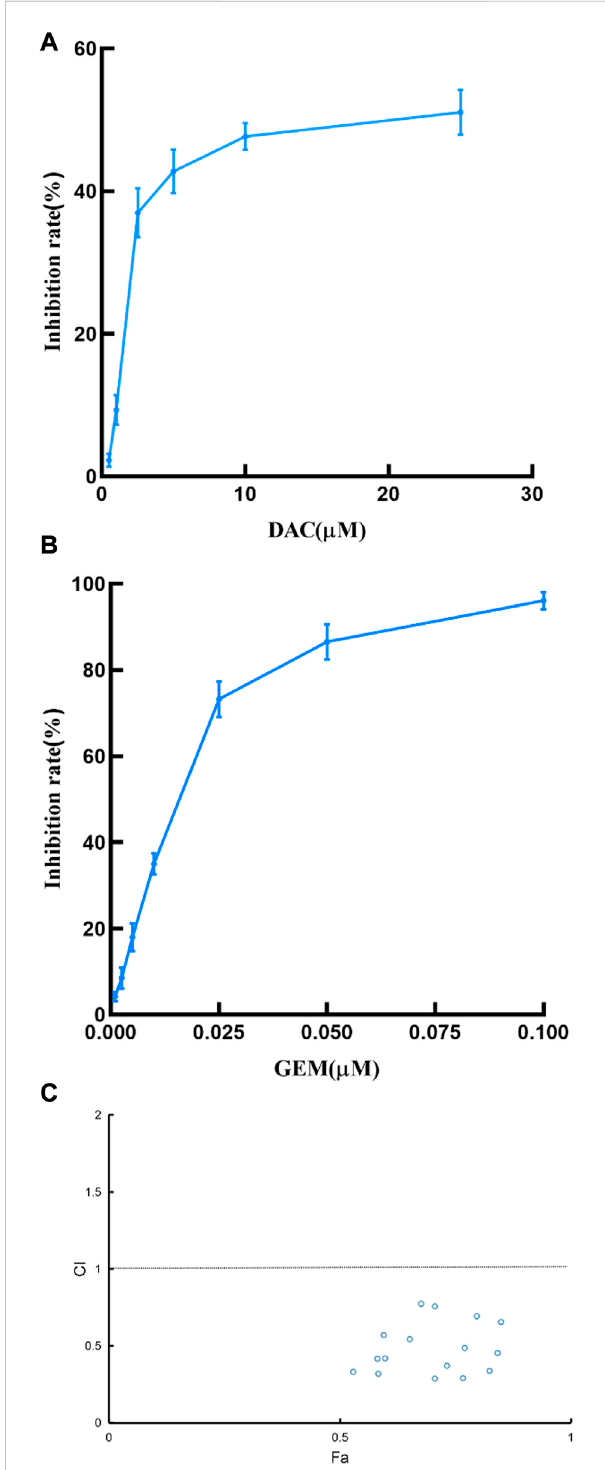
FIGURE 1 Effects of DAC and GEM on NK92MI cell viability and con fi rmation of the best combination of DAC and GEM. (A) Effects of DAC on cell growth in NK92MI cell lines. (B) Effects of GEM on cell growth in NK92MI cell lines. (C) CI plots of DAC and GEM combinations in NK92MI cells. The combination index was estimated using Compusyn software. CI < 1 indicates synergy; CI = 1 indicates an additive effect; CI > 1 indicates antagonism.